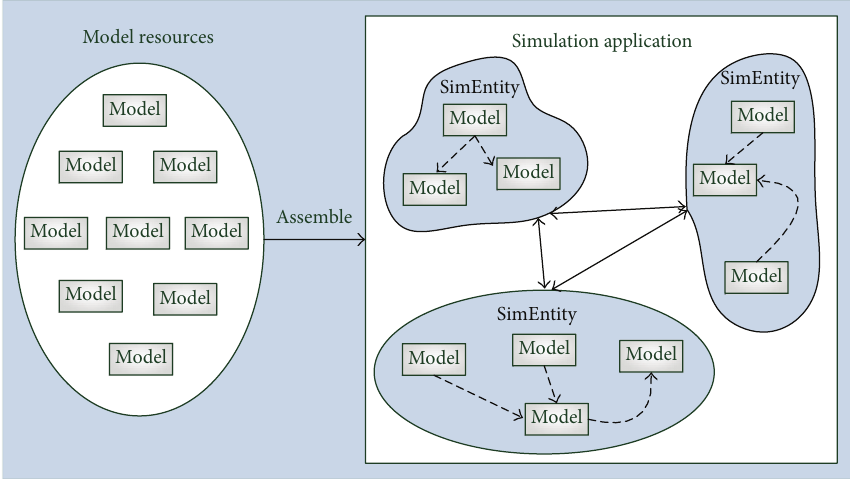
Figure 1: Component model-based simulation application development process in parallel and distributed simulation.